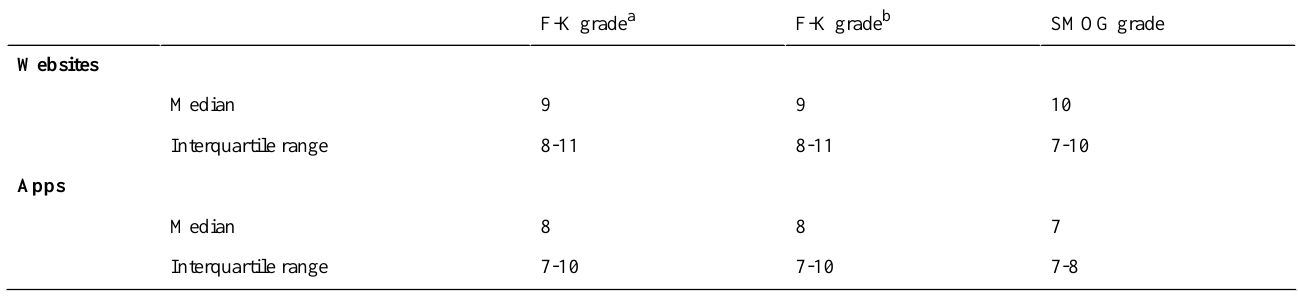
Table 2. Readability